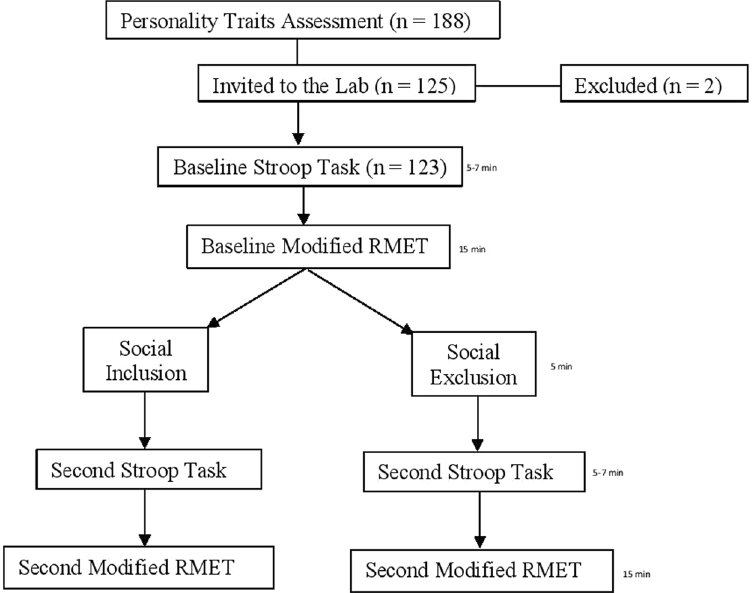
Figure 1. A flowchart of the sampling and study